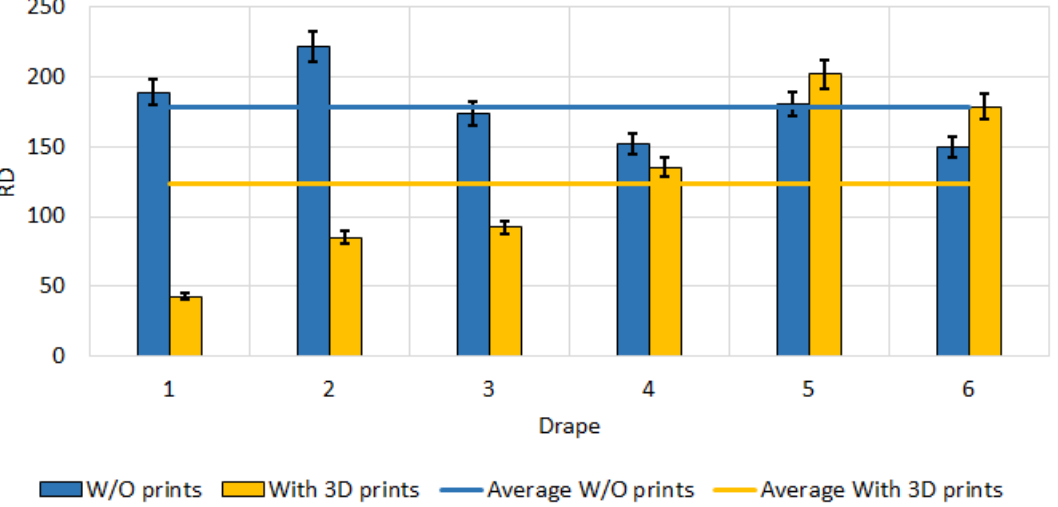
Figure 12. Changes in RD. The values are significantly different at p < 0.05. Figure 13 shows changes in the coefficient of form (K), according to the type of textile with and without 3D prints. Adding 3D printed elements increases the values of the aspect ratio. The highest values of this coefficient are observed in samples with triangle geometry and circle geometry, which have more closely spaced elements compared to the other samples. The lowest values are exhibited bythe sample with three-hexagon geometry. That geometry does not affect the coefficient of form, in comparison with other geome- tries.